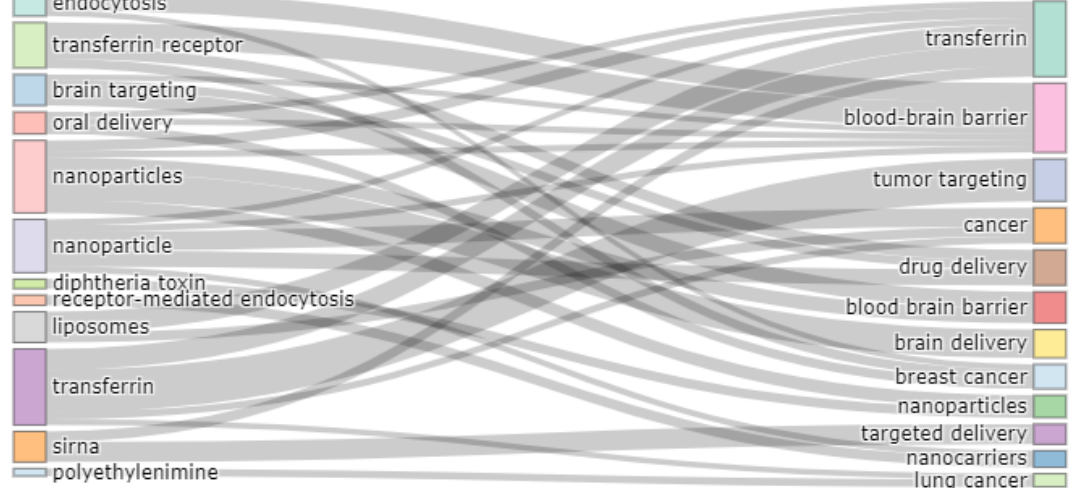
Figure 12. Thematic evolution. Source: Authors’ elaboration using the Bibliometrix R-package.